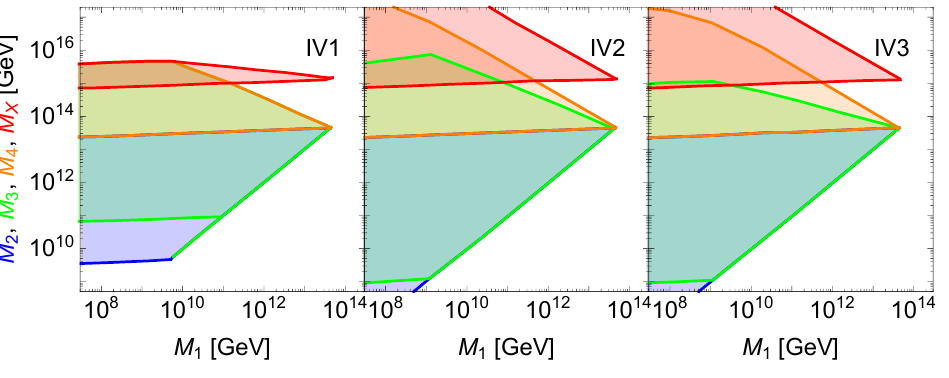
Figure 3 . Prediction of GUT scale, M X , and intermediate scales, M 1 , M 2 , M 3 and M 4 , in type (c) breaking chains with four intermediate scales: SO(10) M X −−→ G